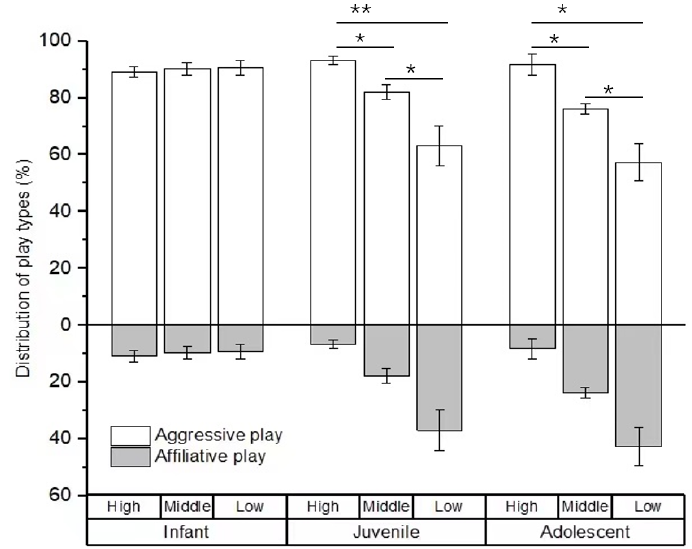
Figure 2. The percentage of play types among immature individuals with mothers of different rank categories. High, middle, and low refer to the social rank of immatures’ mothers (* p < 0.05; ** p < 0.01).